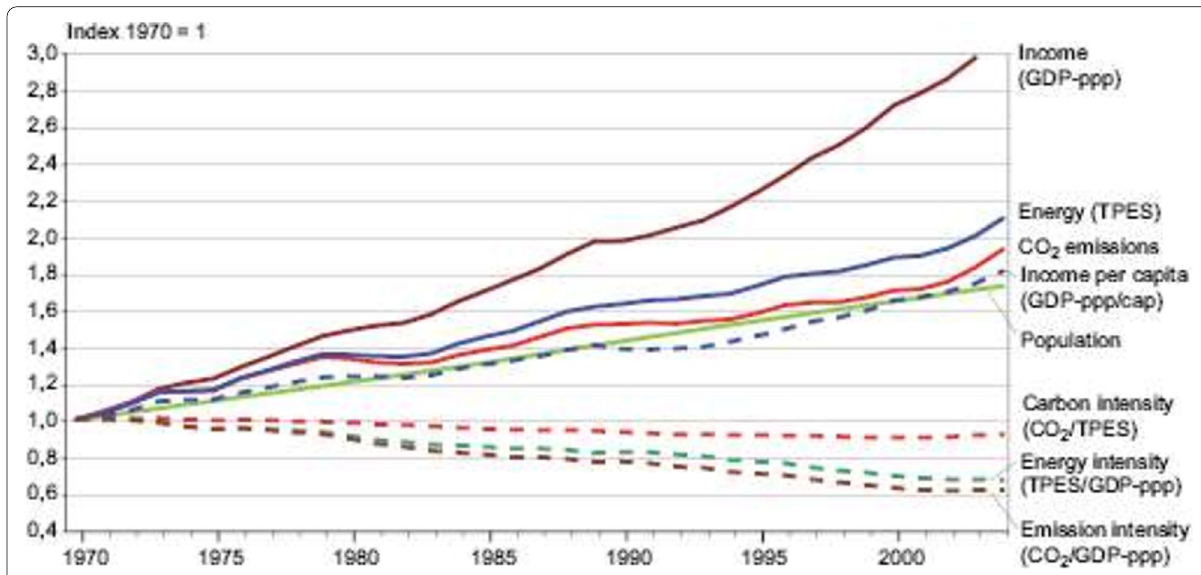
Fig. 1 Global Green House Emissions:‘Figure shown above illustrates schematically the global greenhouse gas emissions over a life-span of approximately 3 decades from the period